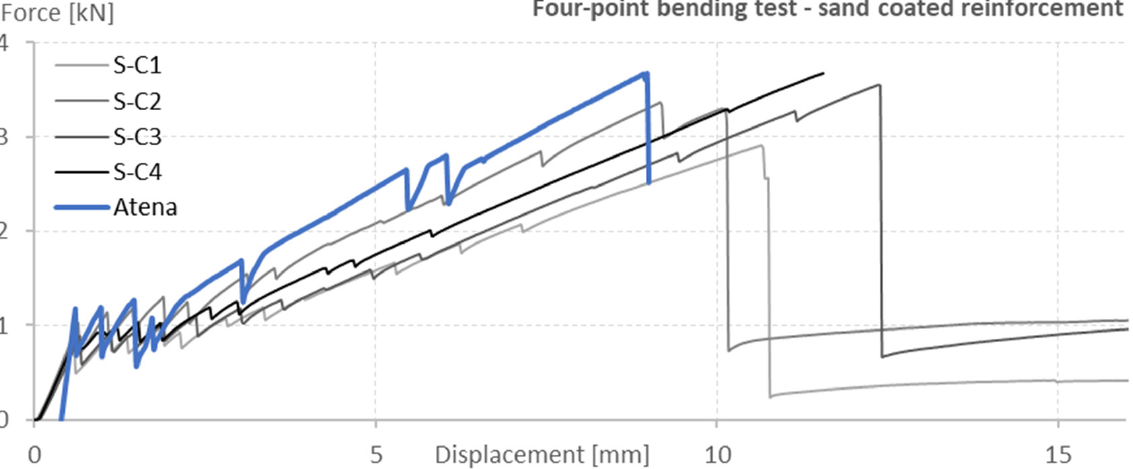
Figure 4. Load ‐ displacement diagram comparison of the real performed four ‐ point bending test of specimens with sand ‐ coated reinforcement and the numerical model prediction.